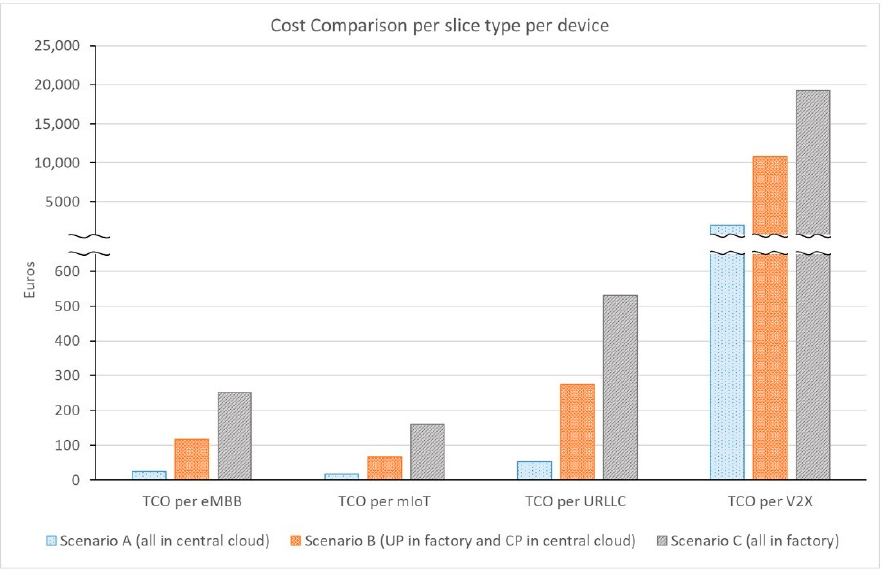
Figure 10. Cost Comparison per slice type, per device type, for different deployment scenarios.